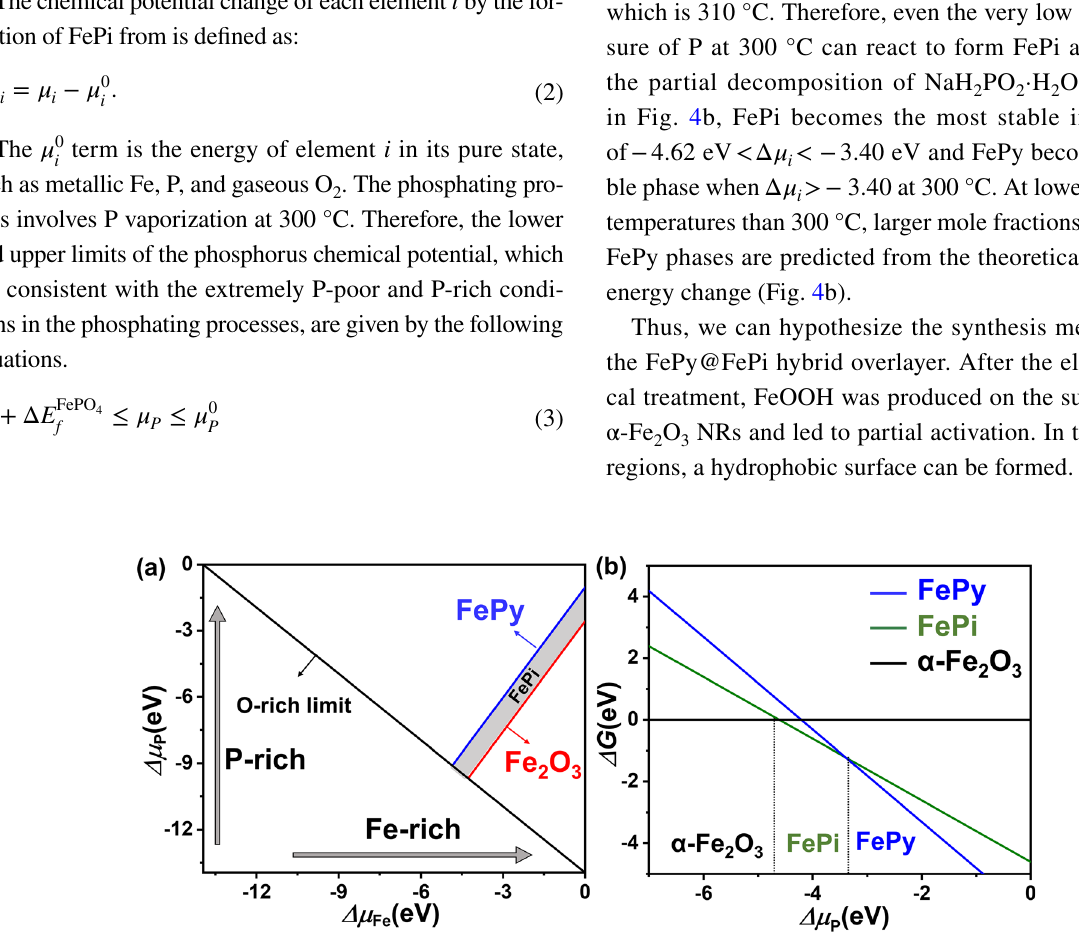
Fig. 4 Theoretically prediction of phosphating process. a Phase space of FePy, FePi, and α‑Fe 2 O 3 under chemical potential variations of Fe, P, and O. b Gibbs free energy change for phase transformation from α‑Fe 2 O 3 to FePi and